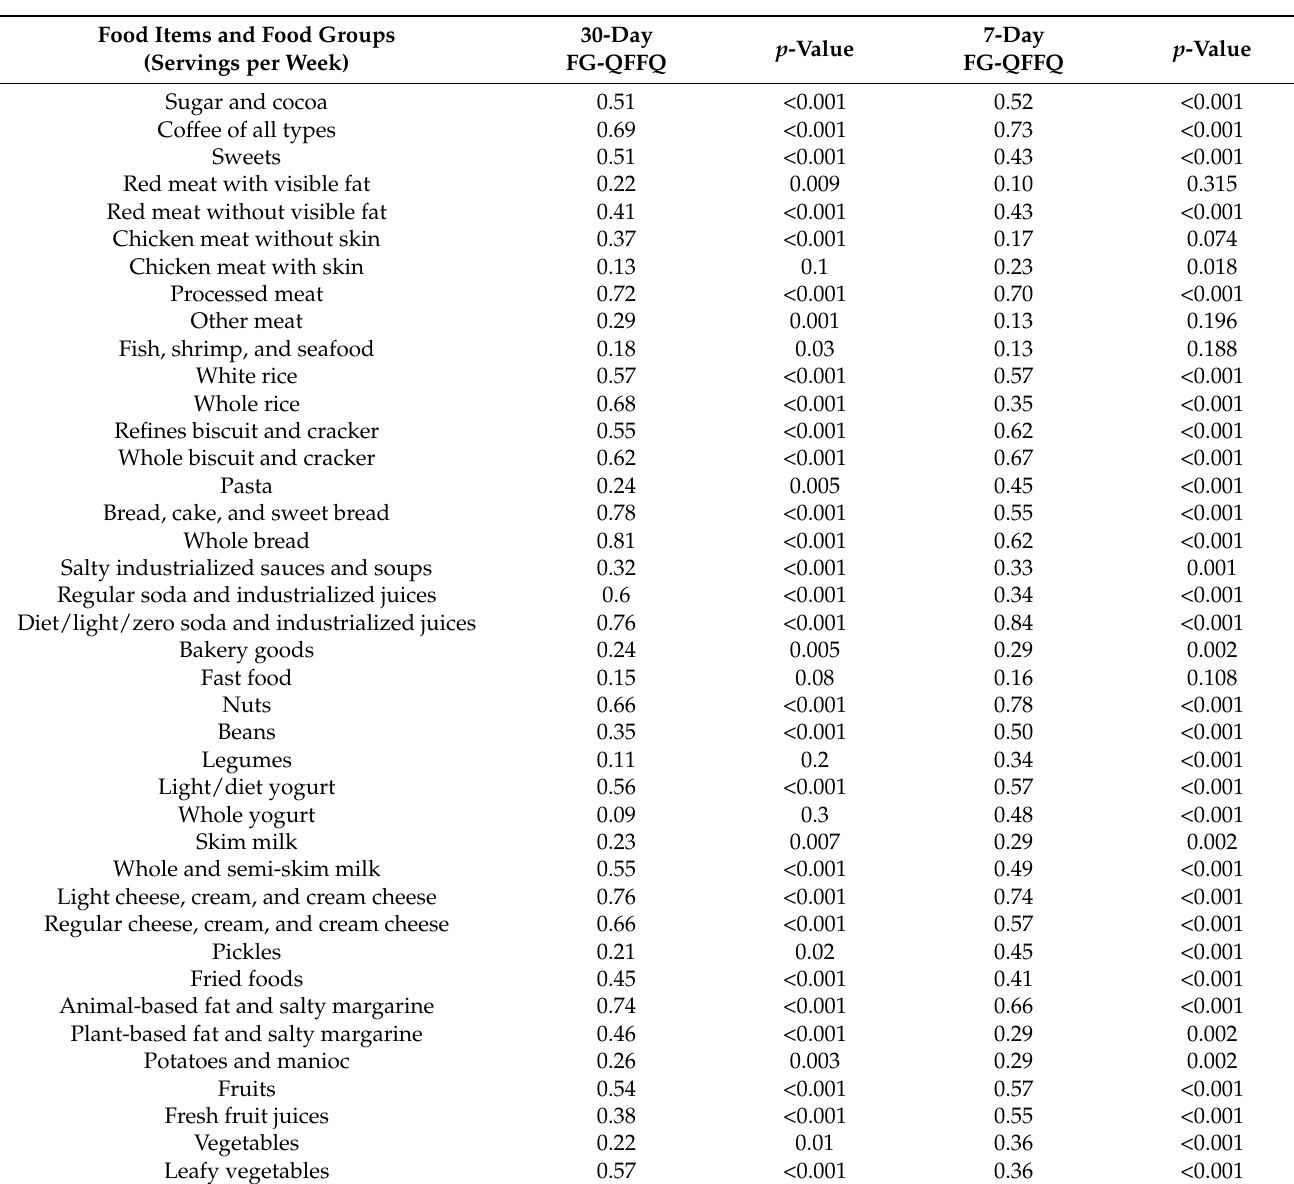
Table 4. Partial correlation coefficient (r) comparing the 30-day FG-QFFQ and the 7-day FG-QFFQ with the 24-h dietary recall adjusted for age and